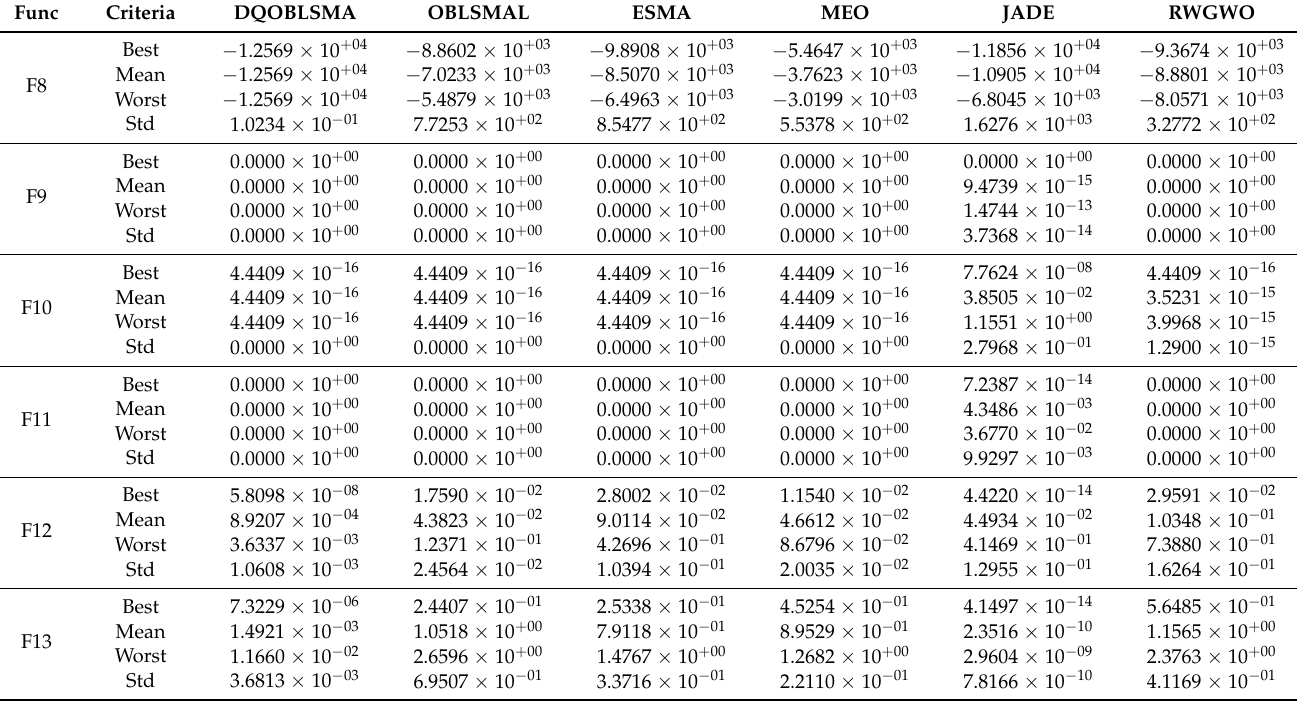
Table 7. Results of multi-modal benchmark